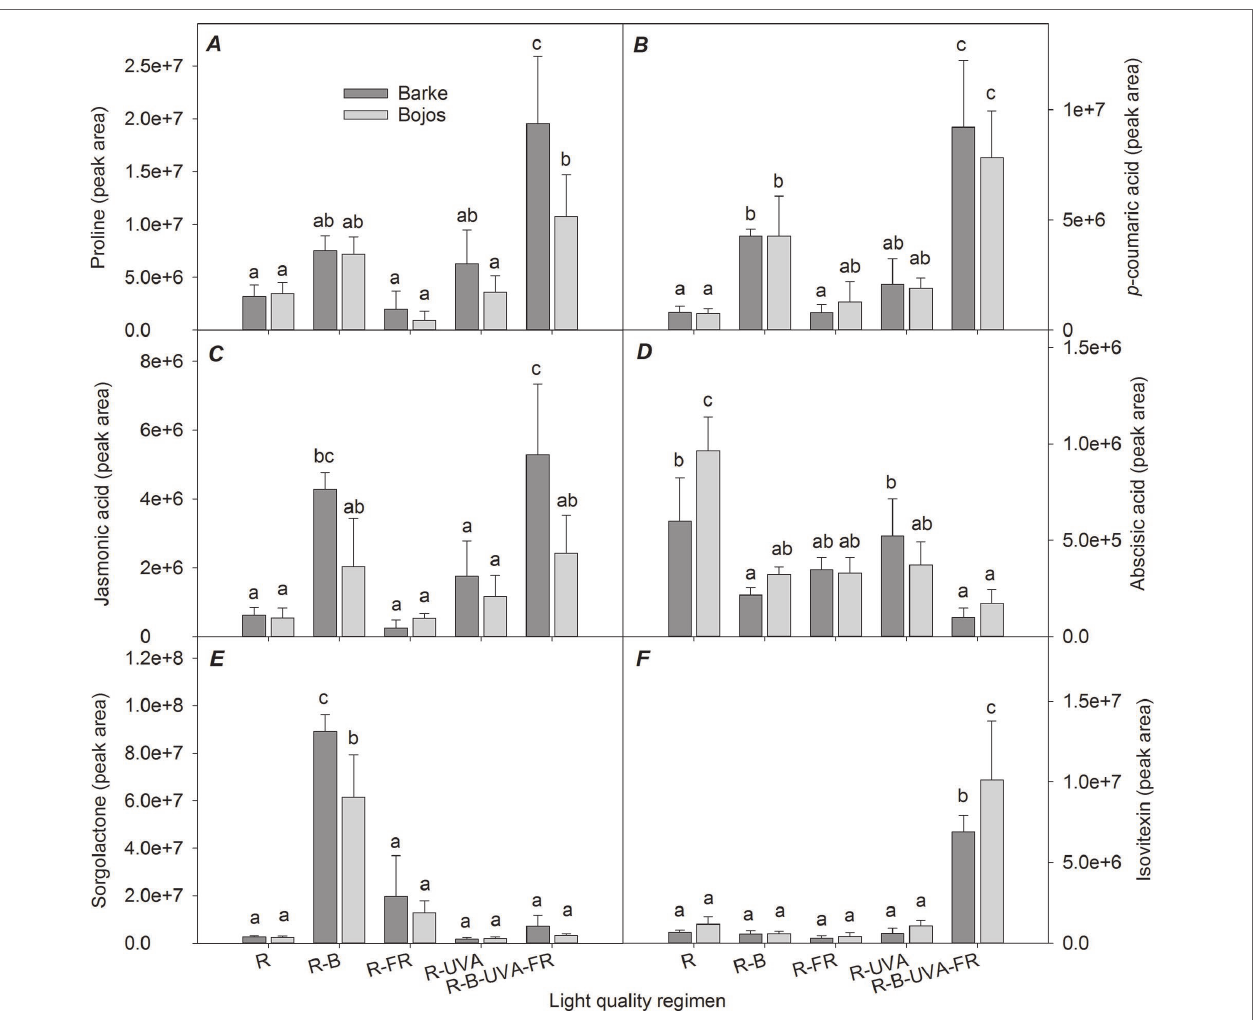
FIGURE 7 | Effects of 26 days exposure to different light regimens on the levels of a representative amino acid (proline, A ), plant hormones or compounds with regulatory effects (jasmonic acid, C ; abscisic acid, D ; sorgolactone, E ), and phenolic compounds ( p -coumaric acid, B ; isovitexin, F ) in leaves of spring barley varieties Barke (dark grey) and Bojos (light grey). Additional details are in the Figure 1